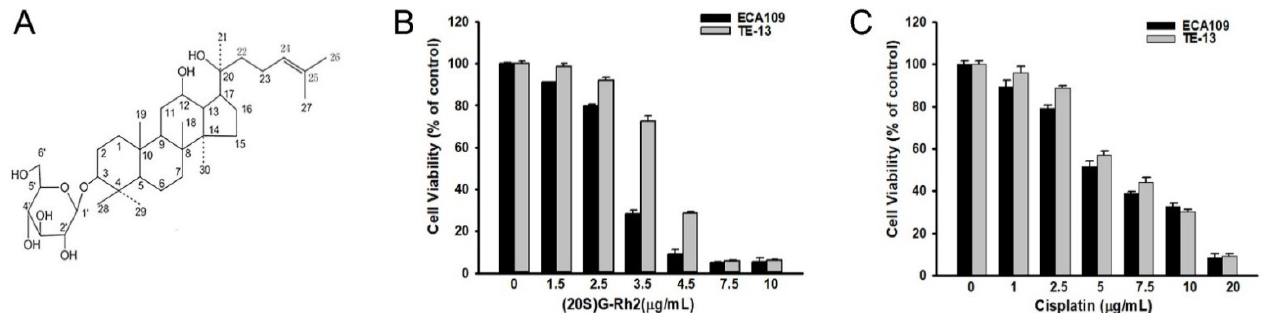
Figure 1. ( A ) Chemical structure of (20S) ginsenoside Rh2; ( B ) cell viability assay of ECA109 and TE-13 cells treated with (20S) ginsenoside Rh2. (20S) G-Rh2 showed cell growth inhibition in